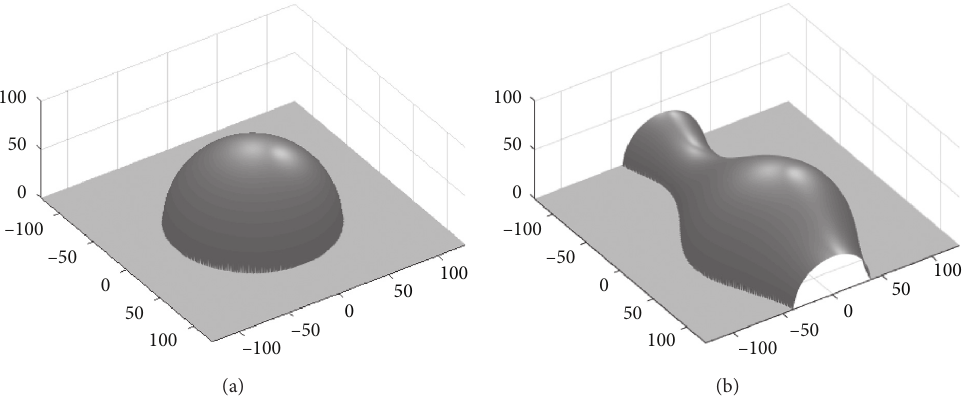
Figure 2: The ground truths of the ball and the vase surfaces. (a) The ball. (b) The